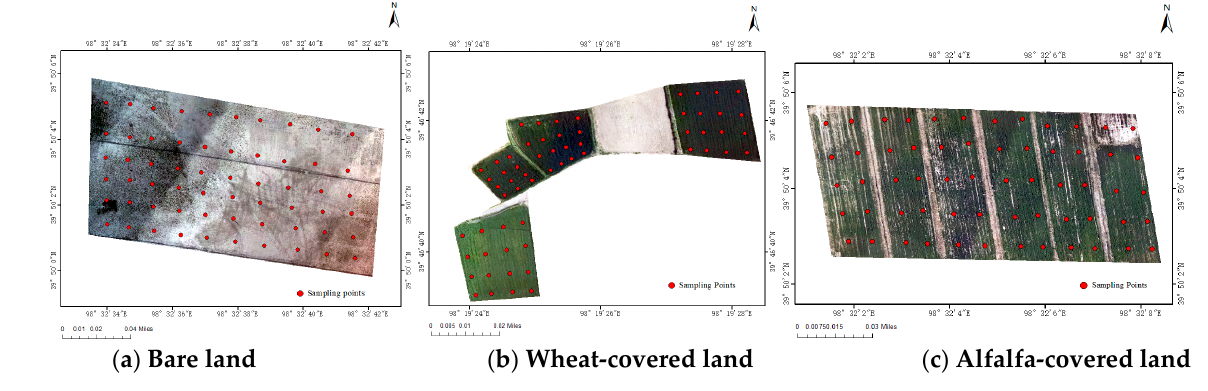
Figure 2. The sampling area.